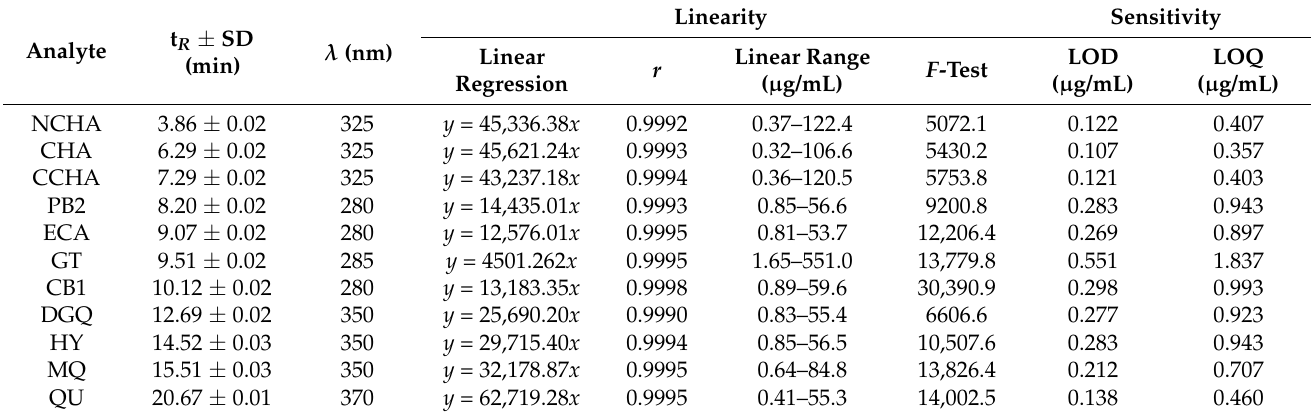
Table 4. Validation data for the proposed HPLC-PDA method.